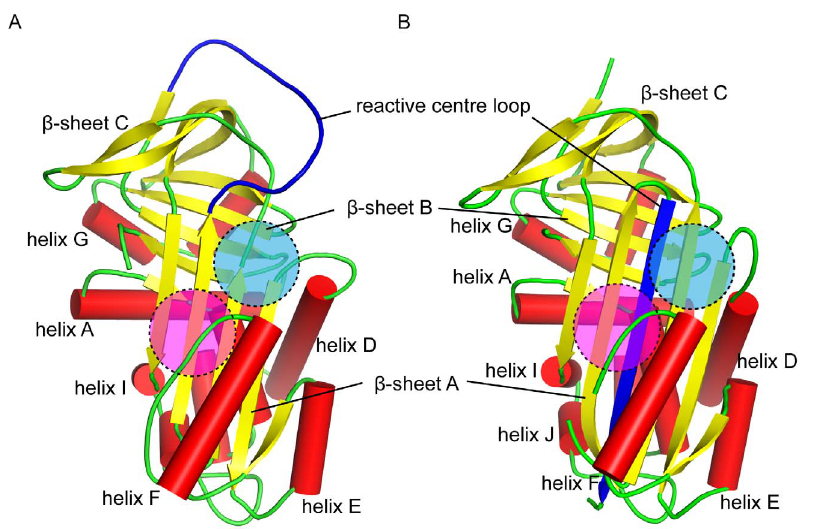
Figure 6. The conserved serpin fold. The canonical serpin fold comprises three b -sheets (yellow), eight to nine a -helices (red) and the reactive centre loop (blue). The proposed sites of the new ligand binding pocket are highlighted in blue (bounded by b -sheet A and helix D) and magenta (bounded by b -sheet A and helix F). (A) The reactive centre loop intact S-state of a typical serpin. (B) The reactive centre loop cleaved R-state of a serpin, showing the insertion of the loop into the middle of b -sheet